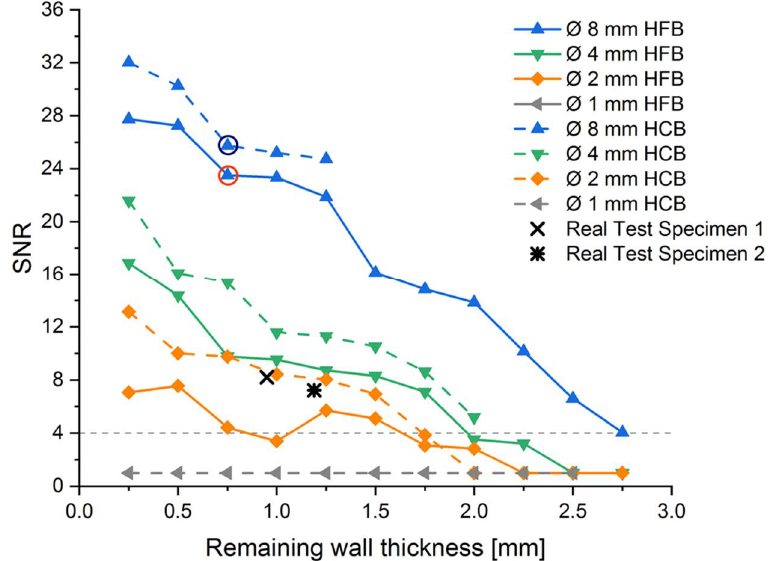
Figure 7. Comparison of the determined SNR values of blind holes with flat bottoms (HFB) and blind holes with conical bottoms (HCB) of diameter 8 mm, 4 mm, 2 mm and 1 mm, as well as the real test specimen.